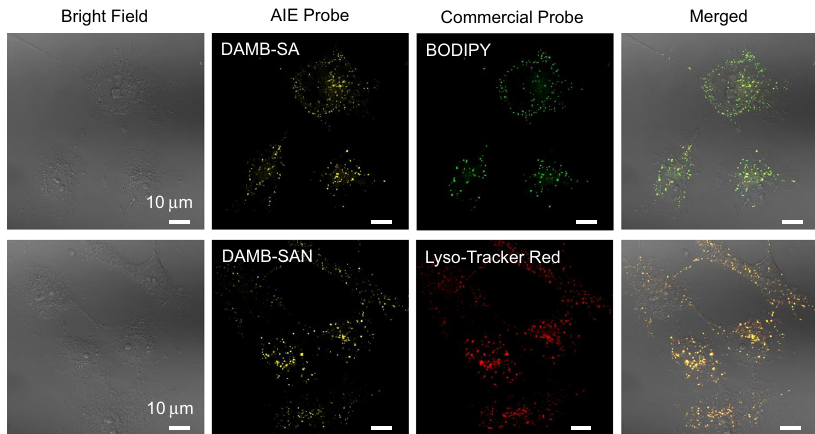
Fig. 5 Targeted imaging. CLSM images of COS-7 cells stained with DAMB-SA (10 µ M), BODIPY (1 µ M), DAMB-SAN (10 µ M), and Lyso-Tracker Red (1 µ M), respectively. DAMB-SA channel: λ ex : 405 nm, λ em : 540 – 600 nm; BODIPY channel: λ ex : 488 nm, λ em : 500 – 530 nm; DAMB-SAN channel: λ λ – 600 nm; Lyso-Tracker Red channel: λ ex : 405 nm, em : 540